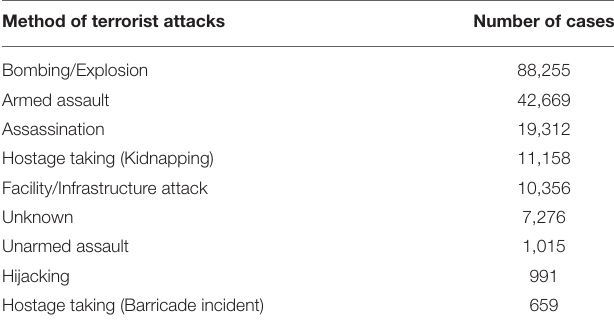
TABLE 1 | The number of different attack types in GTD (Data source: GTD, 1970-2017, attack type statistics using GTD’s variable attacktype 1_ txt ). Method of terrorist